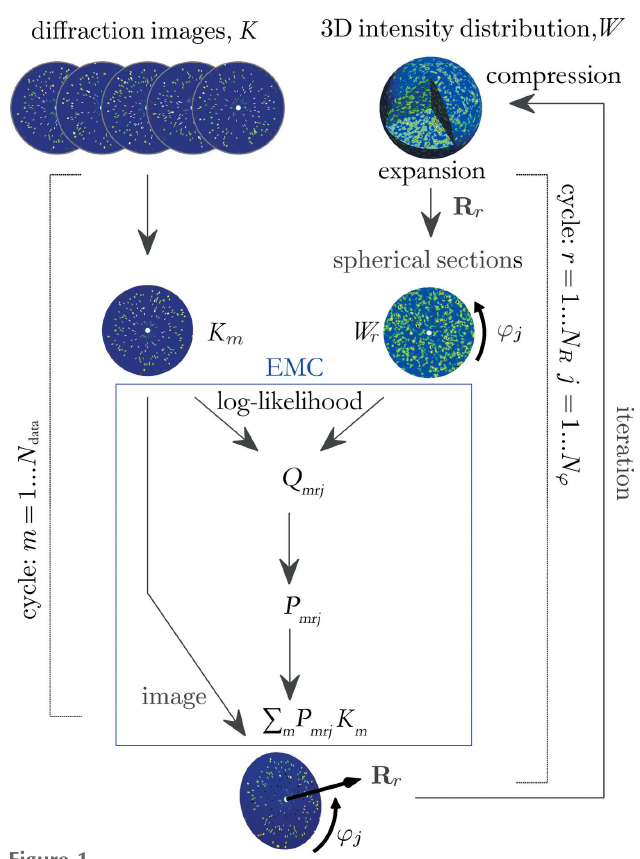
Figure 1 A flowchart of the modified EMC method. The expectation-maximization step is inside the blue